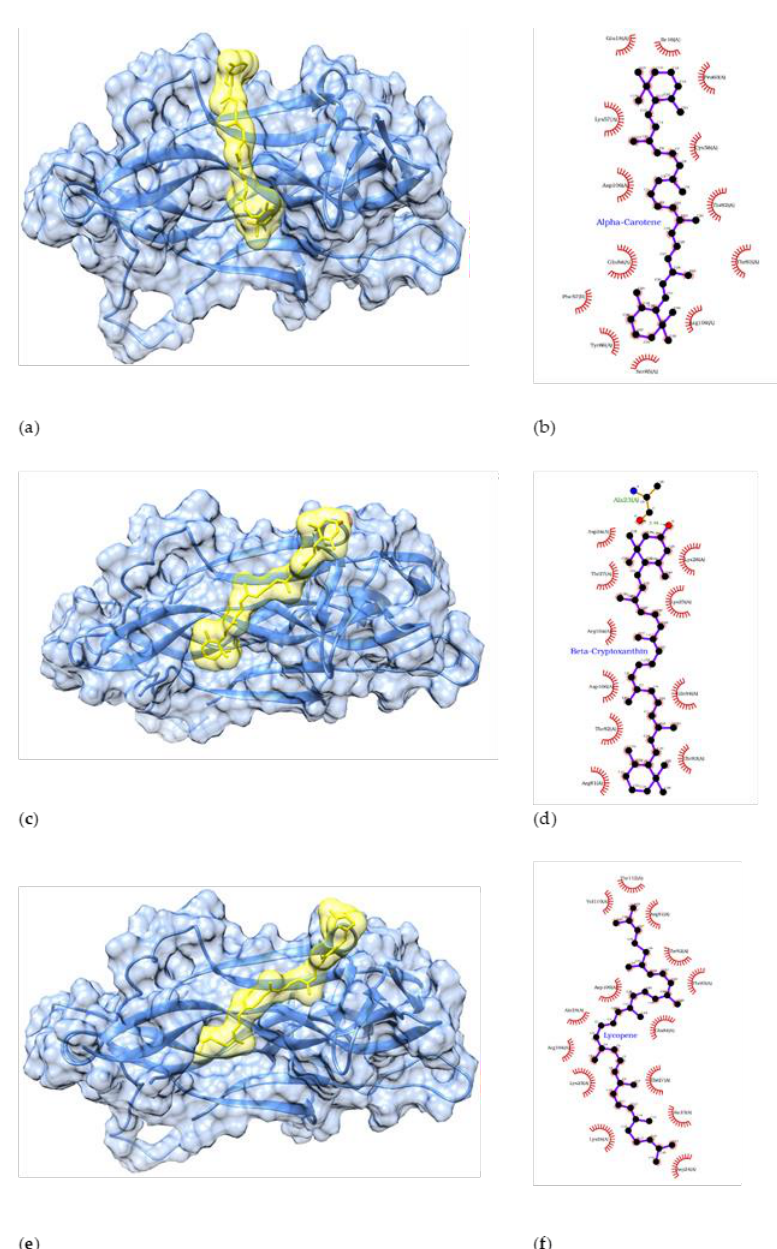
Figure 2. Interaction between the first ranked compound ( α -carotene) with BDNF ( a , b ). Interaction between the second-ranked compound ( β -cryptoxanthin) with the target BDNF protein ( c , d ). Interaction between the third-ranked compound (lycopene) with BDNF protein ( e , f ). In 3D interaction figures, BDNF is shown in blue and compounds in yellow). Table 6. Docking score (EFEB) of selected molecules with MAOA and MAOB.